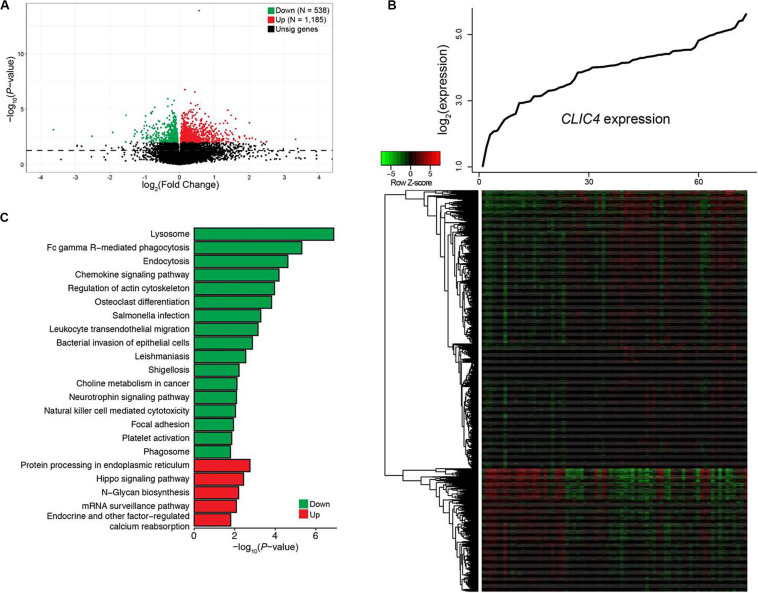
Genome-wide genes/cell signaling pathways associated with CLIC4 expression. (A) Volcano plot of the genome-wide gene profiles between the CLIC4high and CLIC4low groups. (B) Gene expression heatmap. The top curve indicates the expression distributions of CLIC4 in 73 cytogenetically normal acute myeloid leukemia (CN-AML) samples. (C) Cell signaling pathways associated with CLIC4 expression.